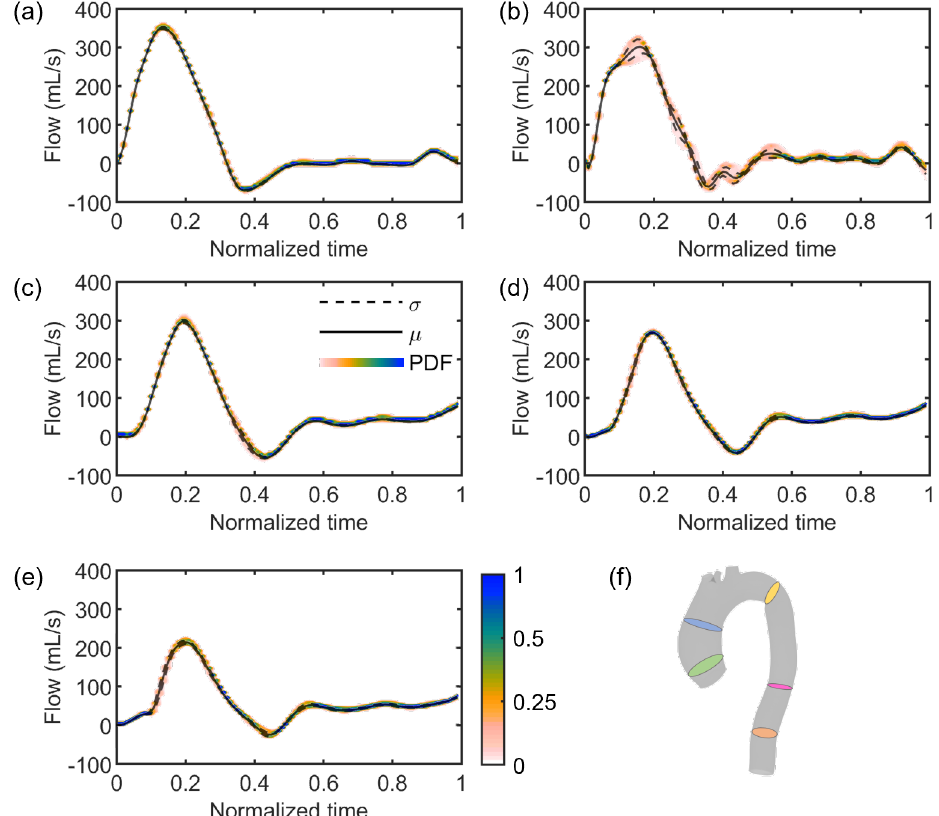
Figure 8. PDF (color scale), mean (straight line), and standard deviation (dashed line) plots of flow variations along the cardiac cycle at cross-sections CS 1 ( a ), CS 2 ( b ), CS 3 ( c ), CS 4 ( d ), and CS 5 ( e ), respectively identified by the green, blue, yellow, pink, and orange slices in the aortic model ( f